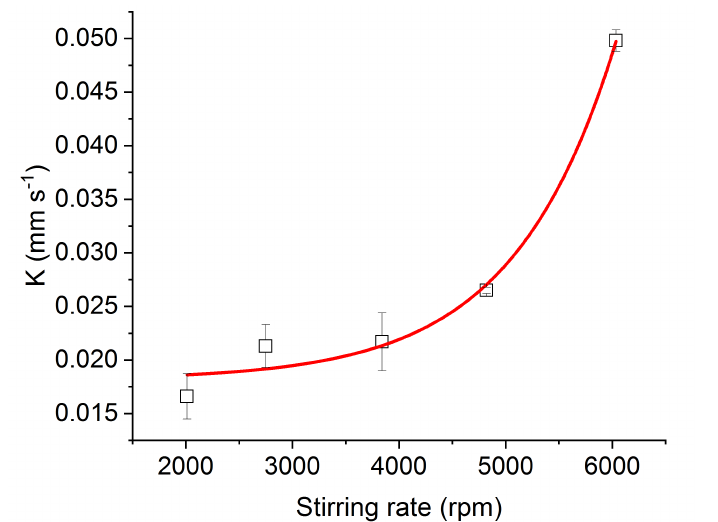
Figure 4. Values of K at different stirring rates. The exponential line has been inserted to highlight the